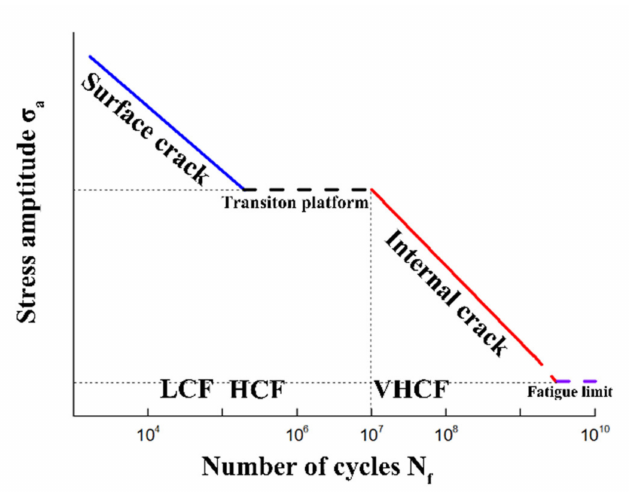
Figure 1. The schematic diagram of two step S-N (stress-number of cycles) curve. LCF, HCF, VHCF indicate low, high, very high cycle fatigue,